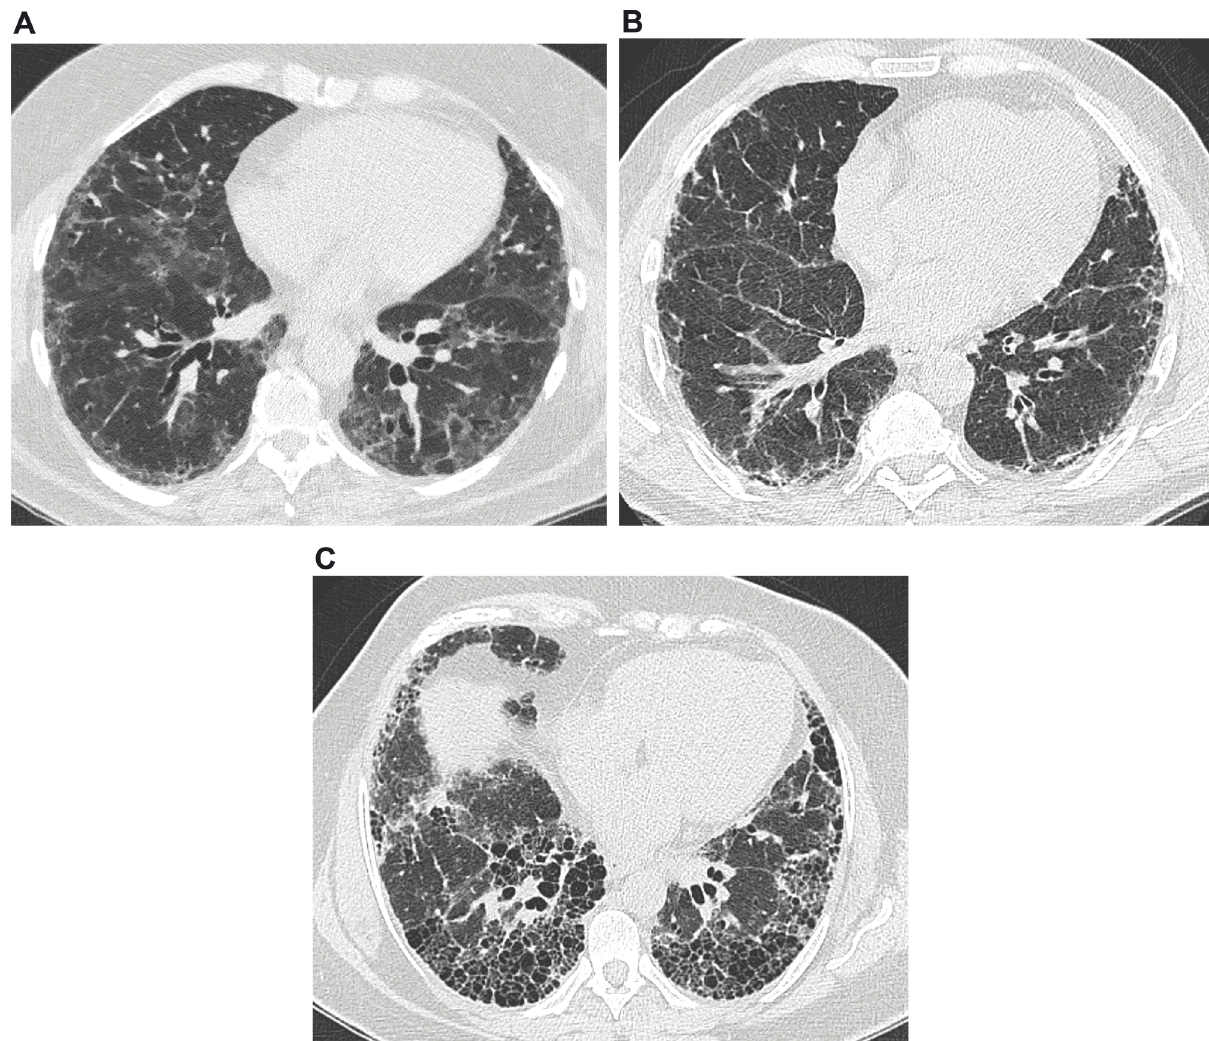
Figure 1 - Common features on high-resolution computed tomography in interstitial lung diseases. (a) Images from a 63-year-old female presenting a nonspecific interstitial pneumonia pattern. There are predominant areas of ground-glass opacities, with some traction bronchiectasis and cortical interlobular septal thickening. (b) Images from a 61-year-old male with idiopathic pulmonary fibrosis. There are diffuse areas of interlobular septal thickening, predominantly in the cortical lung zones. (c) Images from a 56-year-old female with idiopathic pulmonary fibrosis. There are extensive areas of honeycombing, with some interlobular septal thickening.